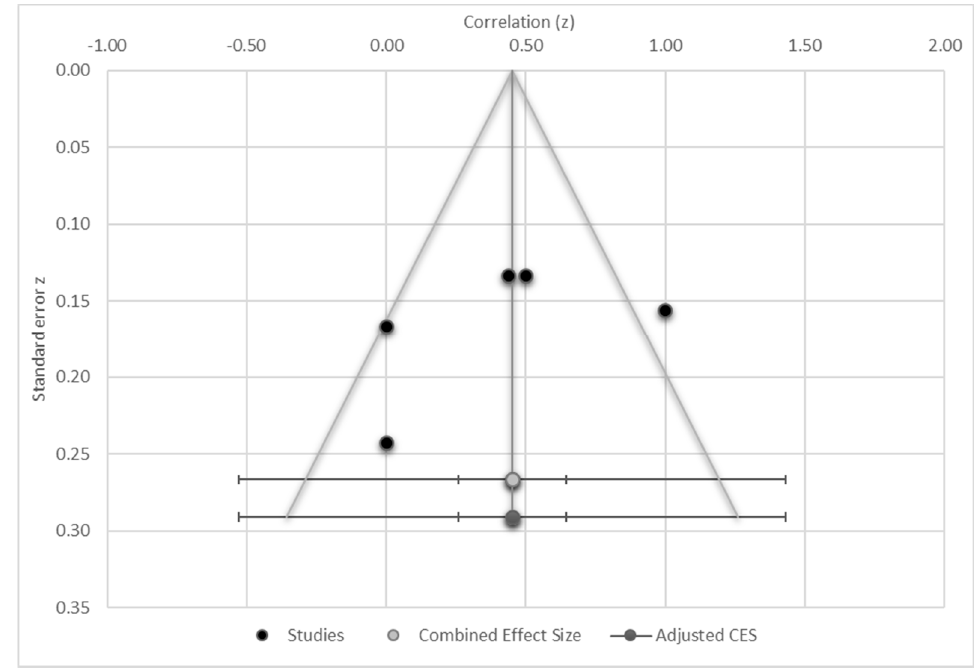
Figure 2. Funnel plot.